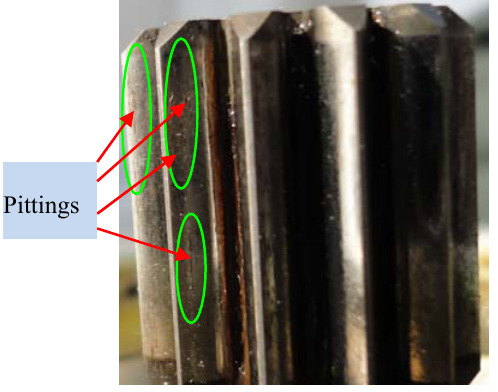
Figure 17. The defects in the sun gear of the planetary gearbox.